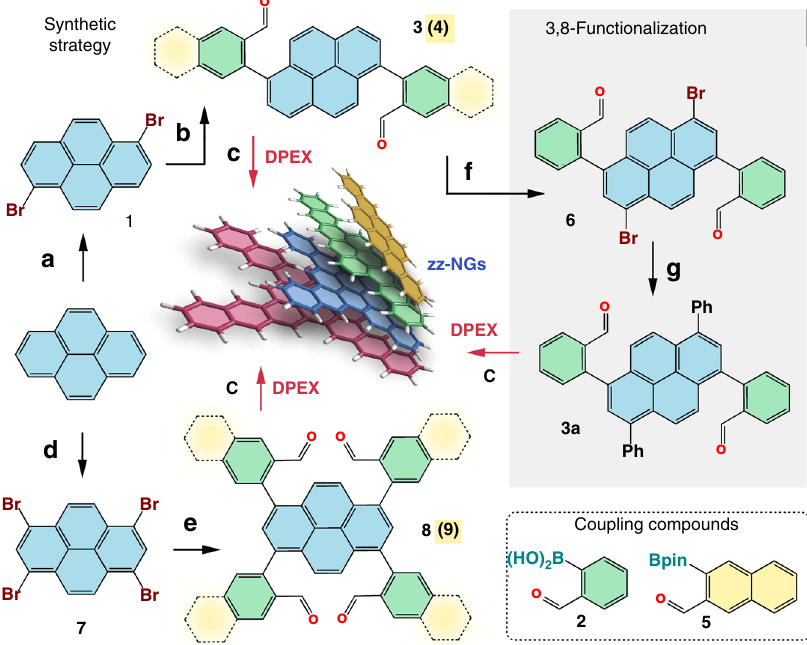
Fig. 2 Synthesis of zig-zag NGs. a CHCl 3 , Br 2 ; b 2:1 toluene/MeOH, 2.5% Pd(PPh 3 ) 4 , K 2 CO 3 , 80 °C, N 2 (3: 61%, 4: 65%); c DPEX : CH 2 Cl 2 , 2 vol% sat. SnCl 2 (cid:129) 2H 2 O/ i -PrOH, 1 vol% conc. H 2 SO 4 , rt, (quant.); d nitrobenzene, Br 2 ; e 2:1 toluene/MeOH, 4% Pd(PPh 3 ) 4 , K 2 CO 3 , 80 °C, N 2 (8: 81 %, 9: 91 %); f CH 2 Cl 2 , 1.6 equiv. HMTAB, rt (quant.); g 2:1 toluene/MeOH, 2.5 % Pd(PPh 3 ) 4 , K 2 CO 3 , 80 °C, N 2 ( 3a : 66 % with phenylboronic acid); HMTAB: